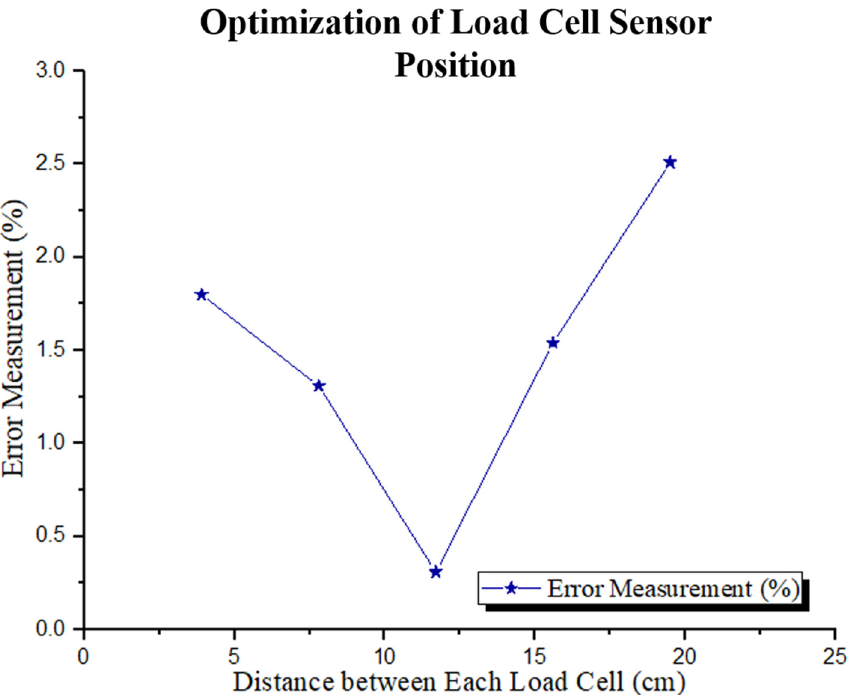
Figure 6. Load cell sensor distance optimization graph. The position of the sensor with the small percentage of error (%) is at a distance of 11.7 cm, which is 0.31%. percentage of error (%) is at a distance of 11.7 cm, which is